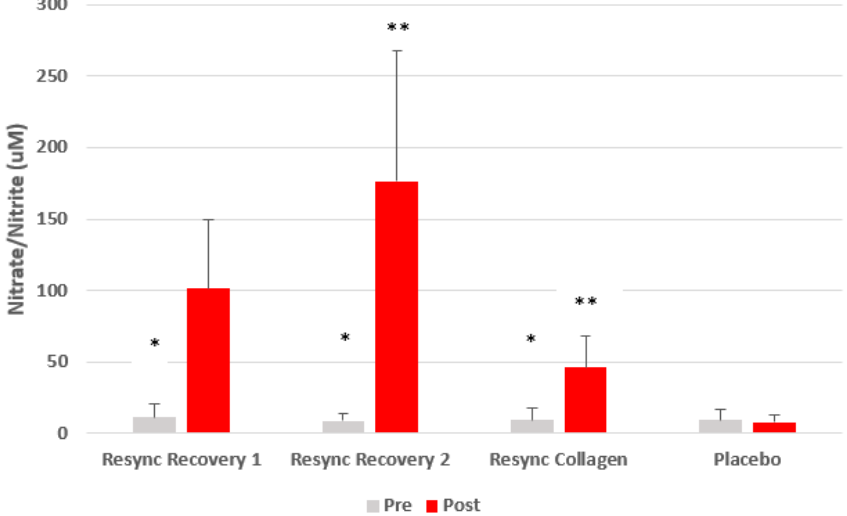
Figure 4. Nitrate / nitrite before and 75 min after ingestion of Resync or placebo. Values are the mean ± SD; total nitrate + nitrite. * Statistical significance from pre- to post-ingestion noted for Resync Recovery 1 ( p < 0.0001), Resync Recovery 2 ( p < 0.0001), and Resync Collagen ( p = 0.002); ** post-ingestion Resync values are greater than post-ingestion placebo values ( p < 0.05); no di ff erences noted for pre-ingestion values between conditions ( p > 0.05). Note: Resync Recovery 1 = 1 serving; Resync Recovery 2 = 2 servings.